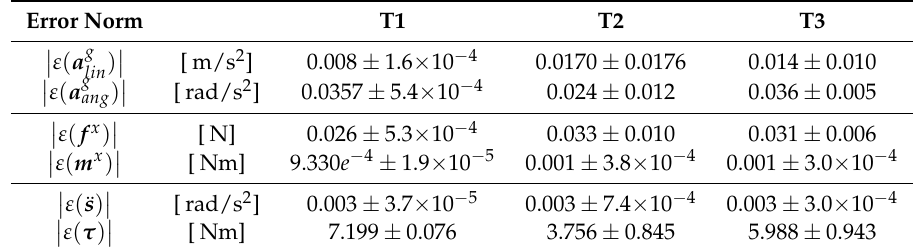
Table 4. Mean and standard deviation of the error norm for: ( i ) the base proper body linear acceleration related to Figure 11; ( ii ) the external wrench related to Figure 12; and ( iii ) the joint acceleration and torque related to Figure 13, for tasks T1, T2 and